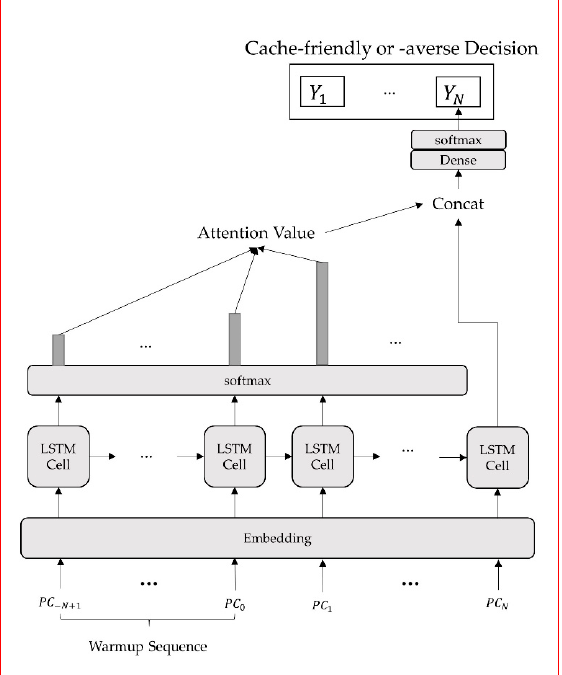
Figure 13. Attention-based LSTM Model [15]: LSTM received a sequence of PC recurrently as an input and predicts the cache priority for current